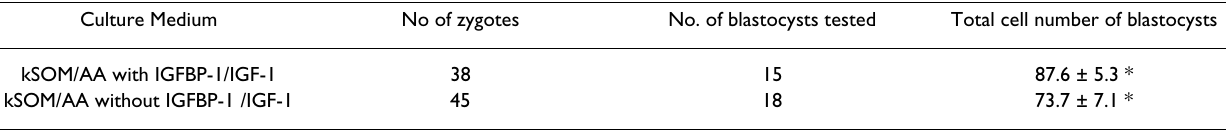
Table 4: Dephosphorylated IGFBP-1/IGF-1 complex increases the total cell number of cultured blastocysts. Culture